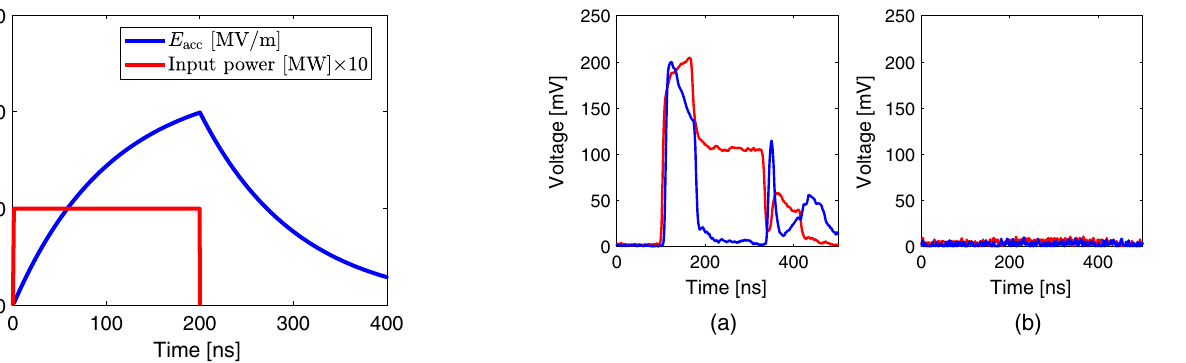
FIG. 10. 200 ns rectangular input pulse and the E the structure (THU-CHK-#1).